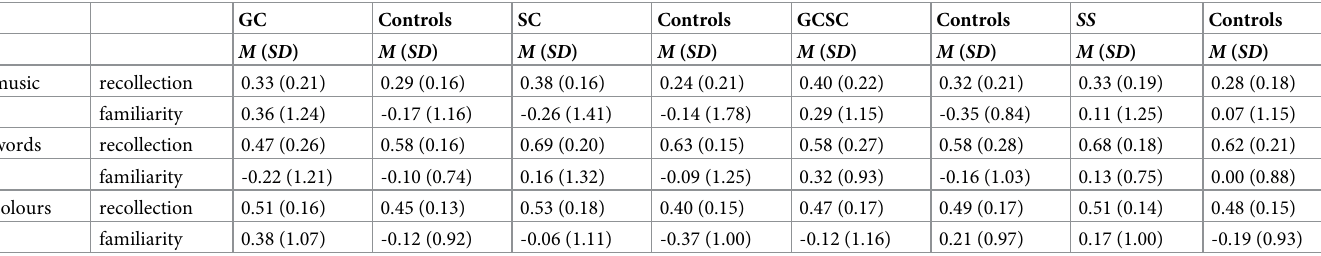
Table 2. Estimates of recollection and familiarity for each type of synaesthesia and stimuli.